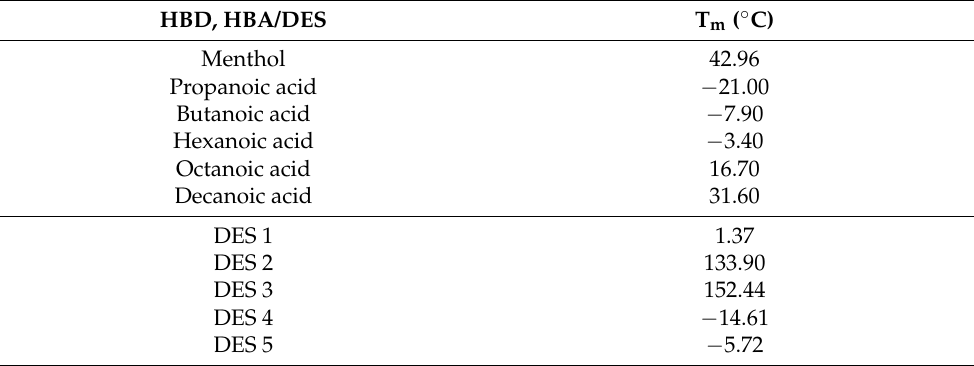
Table 1. Melting points for menthol and DESs determined throughout the